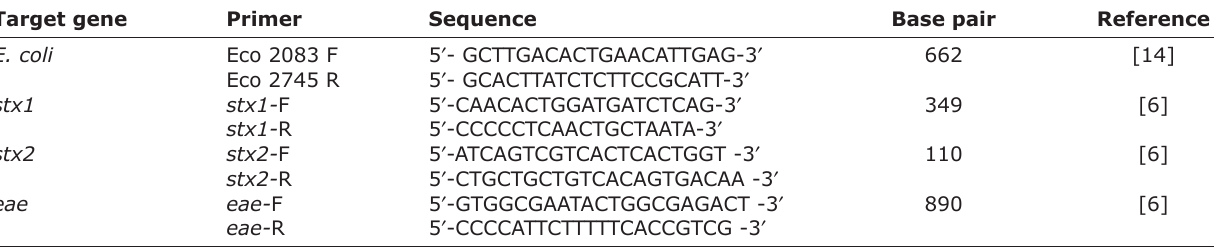
Table-2: Characterization of the recovered E.coli by multiplex PCR from traditional dairy product samples. Types and number of collected traditional dairy product samples